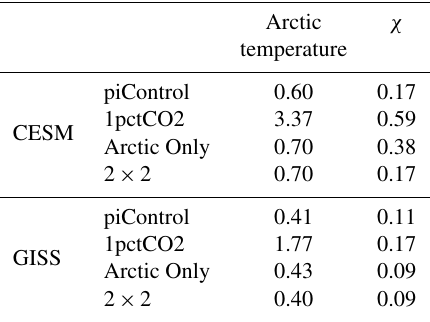
Table 1. Root-mean-square (RMS) differences in Arctic temper- ature ( ◦ C) and χ (Eq. 1; degrees latitude) from the temperature and latitude objectives. Values are calculated over the entire 70-year simulation as the RMS of interannual deviations from the preindus- trial control (piControl)